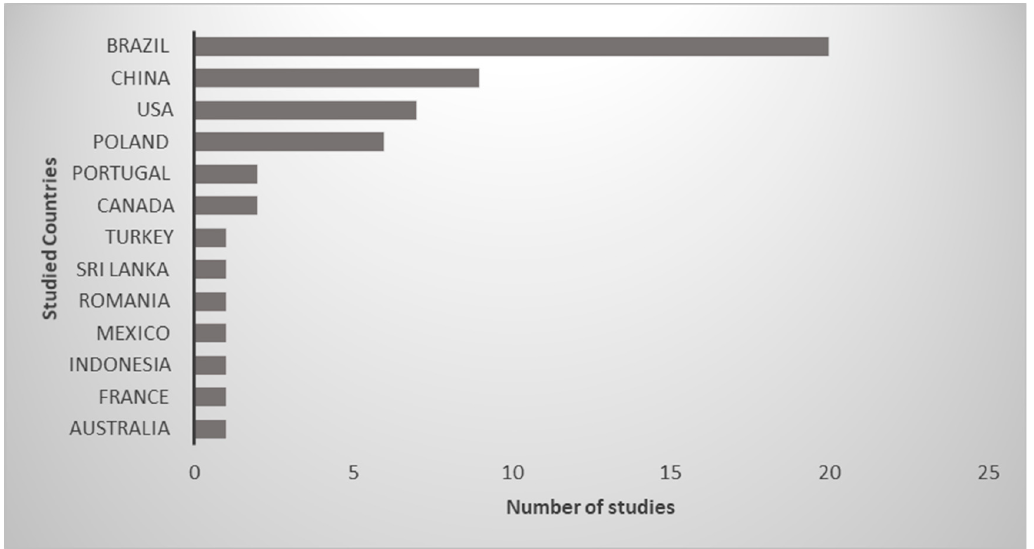
Figure 2. Countries where the eutrophic urban reservoirs were located 1992–2018.